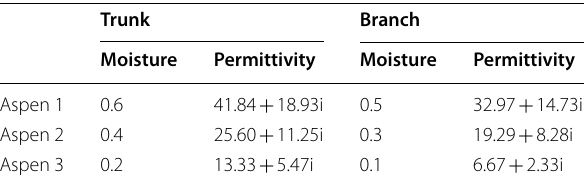
Table 5 Vegetation water content and permittivity for the 3 scenarios